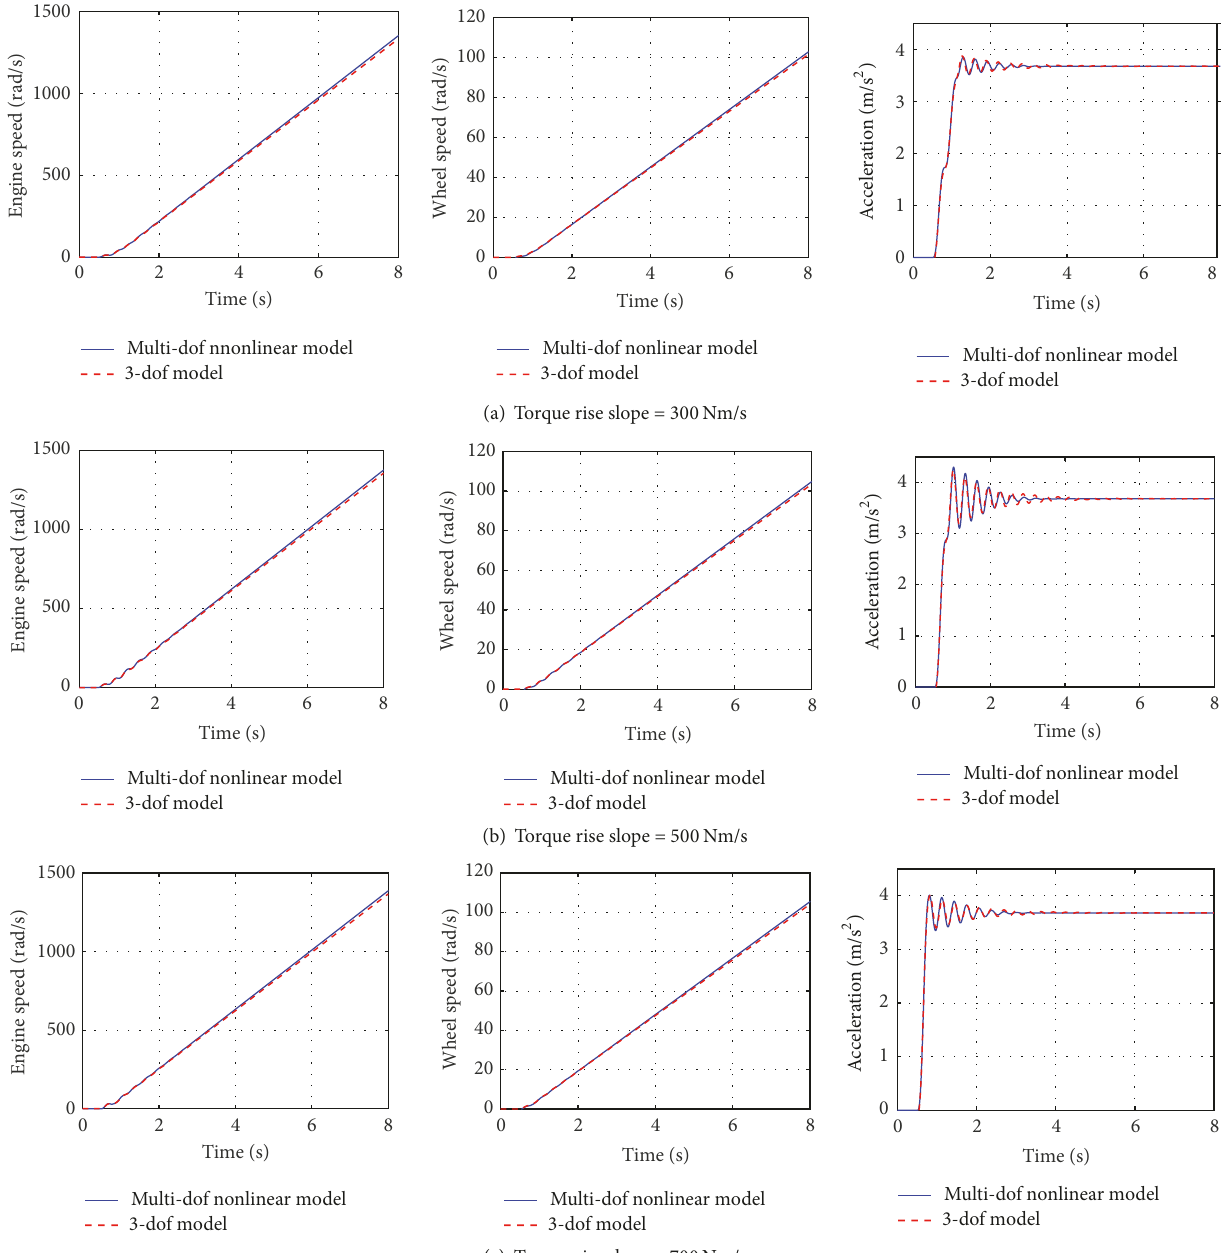
Figure 22: Reference variables compared between the 3-dof model and the detailed